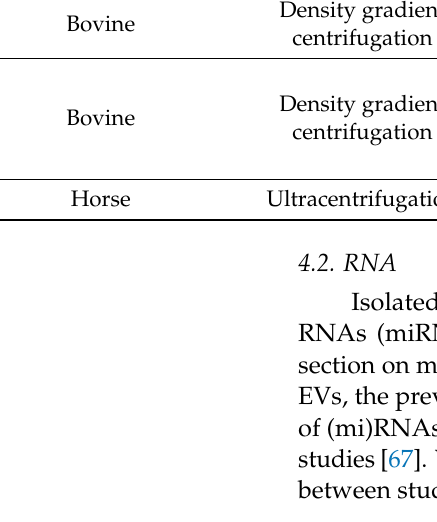
Table 4. Main microRNAs identified in isolated extracellular vesicles from human